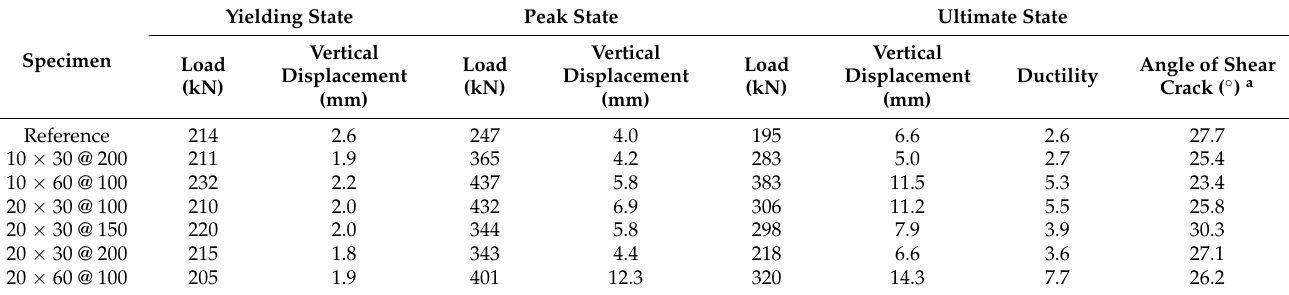
Table 3. Test results.